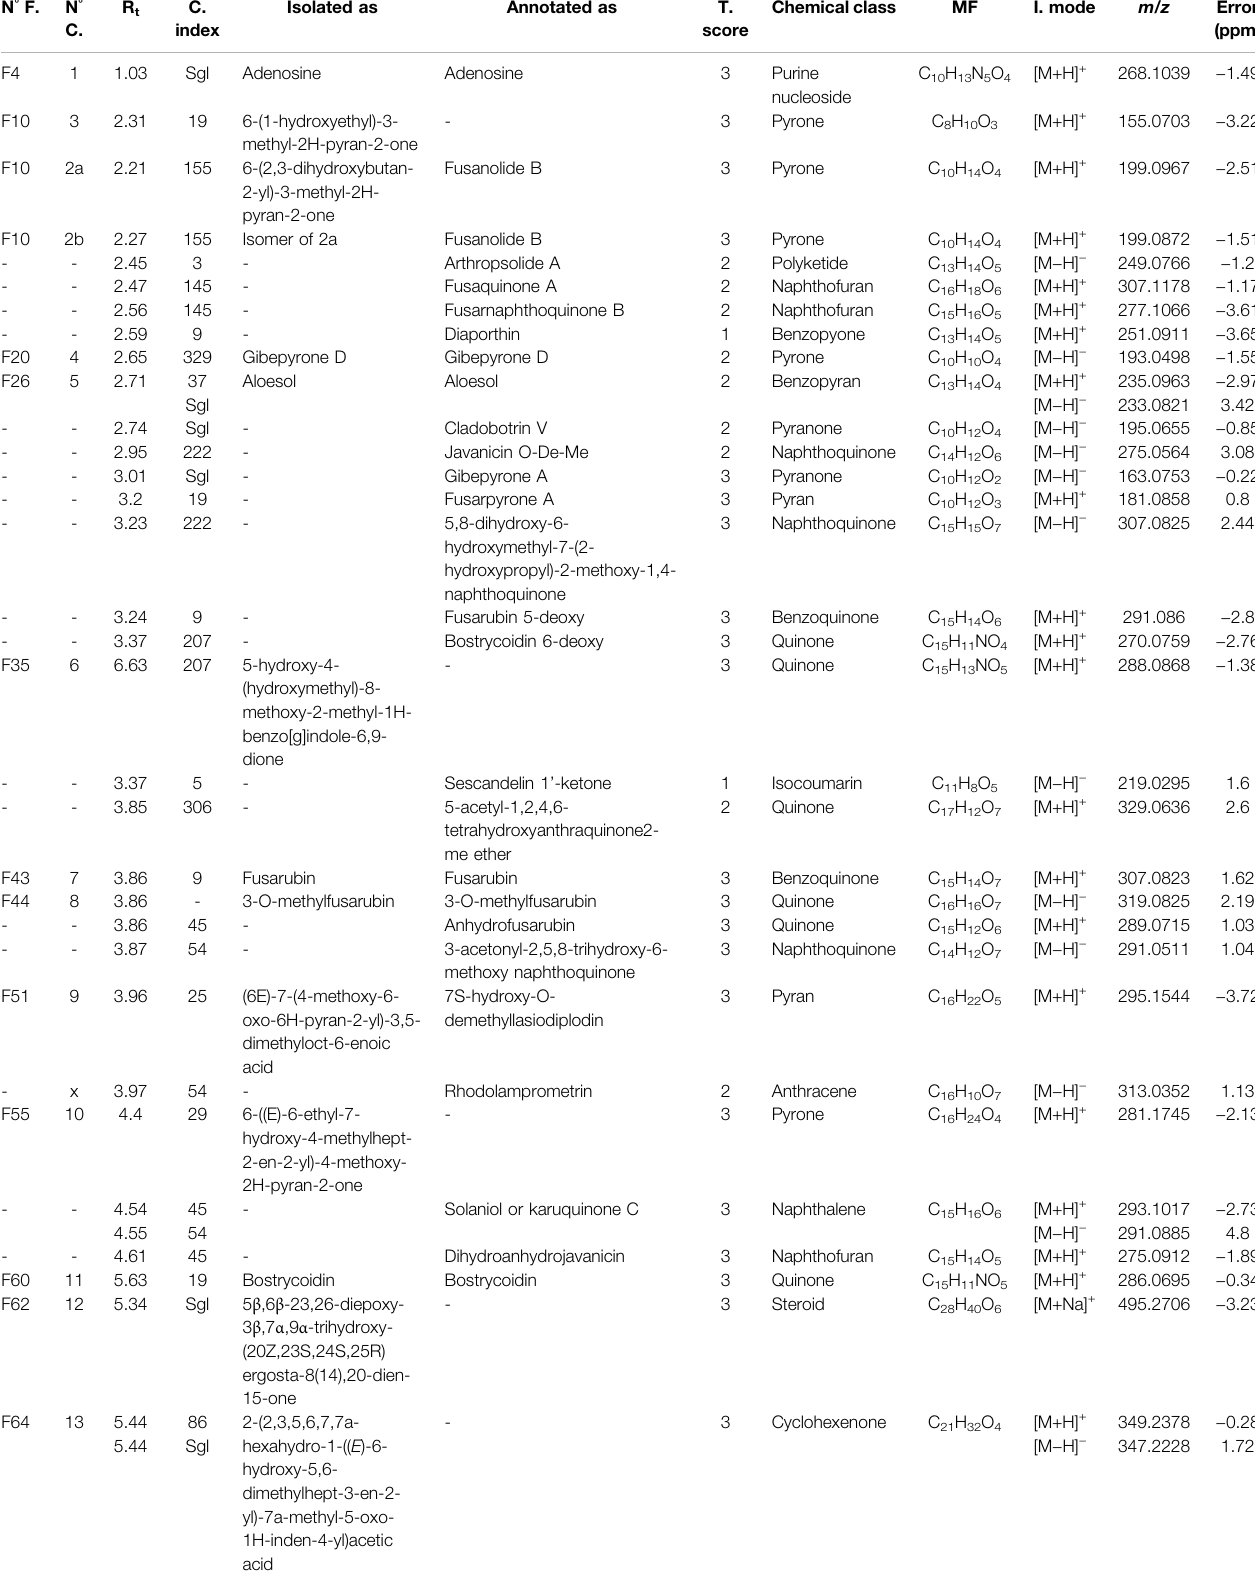
TABLE 2 | Annotated compounds by UHPLC-HRMS/MS in both PI and NI modes in the crude extract of F. petroliphilum . N °